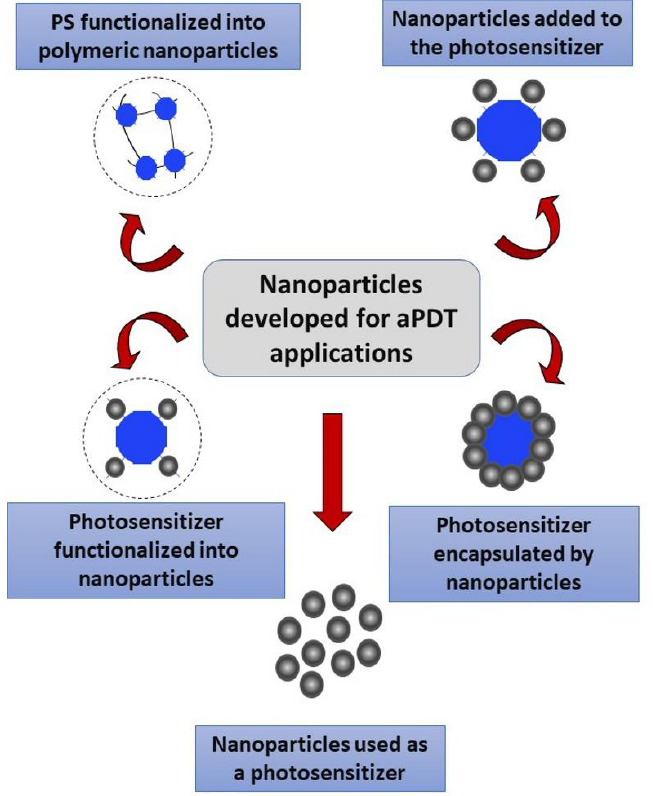
Figure 5. Most remarkable strategies where nanotechnology is applied to PS to enhance the aPDT disinfection outcomes.